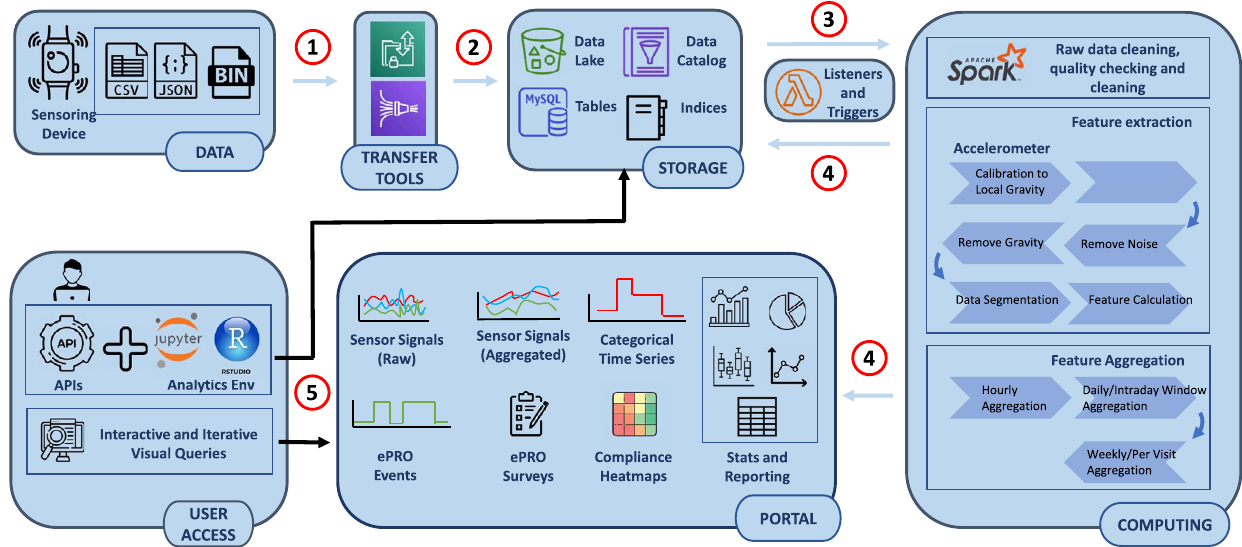
Fig. 9 A typical data fl ow in data platform. ① – ⑤ indicate the data fl ow sequence order: ① digital data ingestion, ② digital data landing in DDR repository and getting structured, ③ newly arriving digital data triggering micro-services for further processing and transformation, ④ data reporting and visualization being updated with newly arriving digital data and derived measures, and ⑤ digital data delivered through